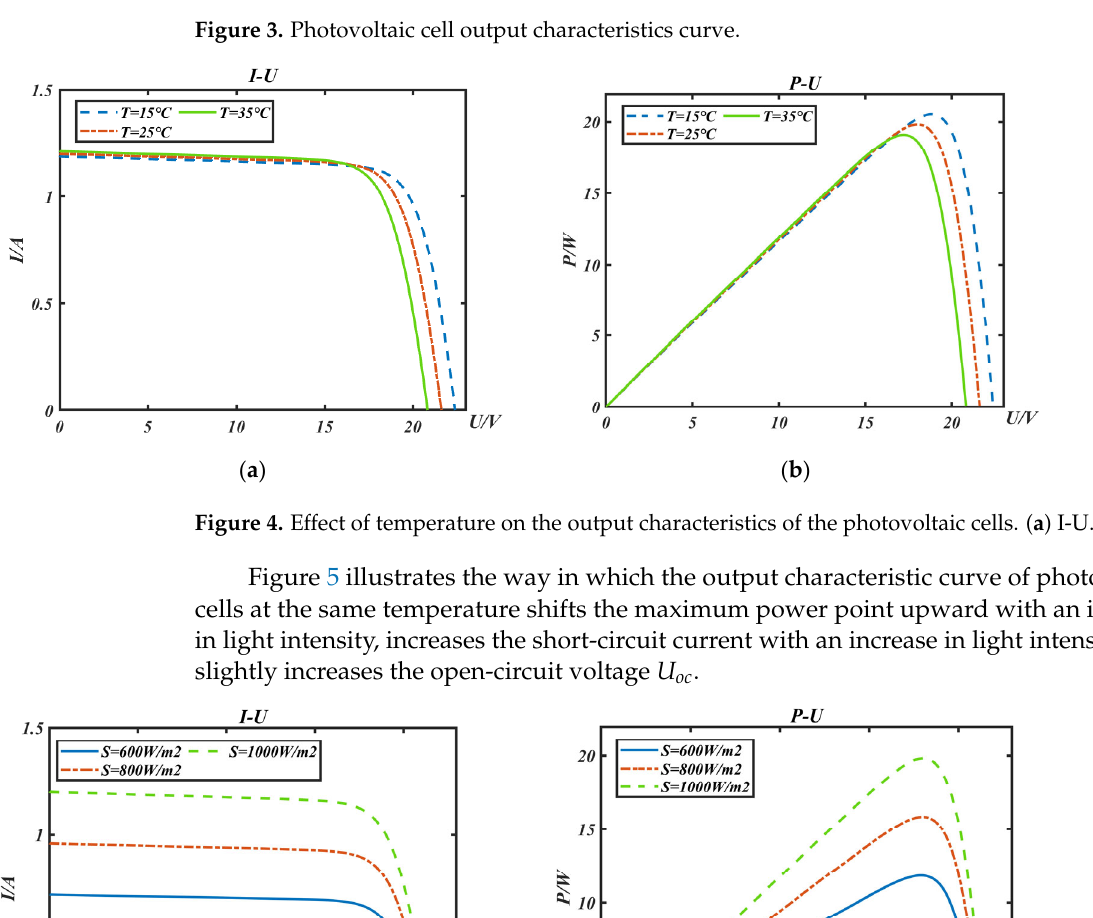
Figure 4. Effect of temperature on the output characteristics of the photovoltaic cells. ( a ) I ‐ U. ( b ) P ‐ U.